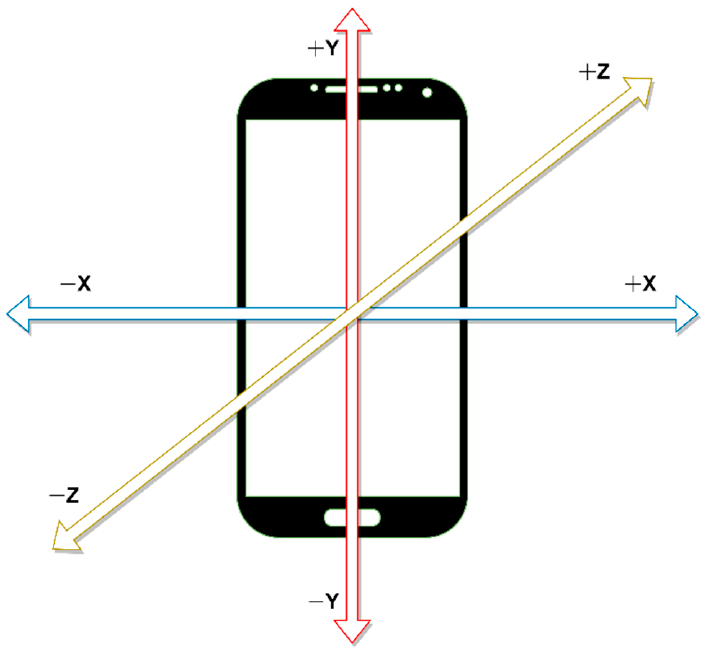
Figure 2. The direction of three axes of an accelerometer sensor in a smartphone.